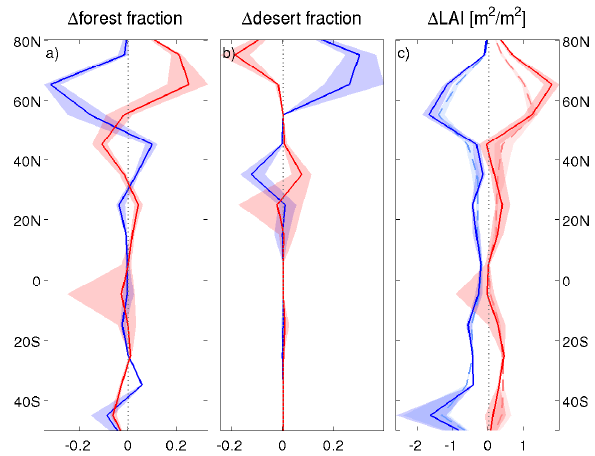
Fig. 8. Zonal forest, desert and LAI anomalies relative to preindus- trial for experiments with fully interactive vegetation (RPLV). CO 2 of 140ppm (blue) and 560ppm (red). Solid lines indicate the me- dian and the shading represents the 5–95 percentile range of the ensemble. For LAI also the anomalies for the RPL experiment are shown (dashed lines). LAI anomalies are computed from values in the peak growing